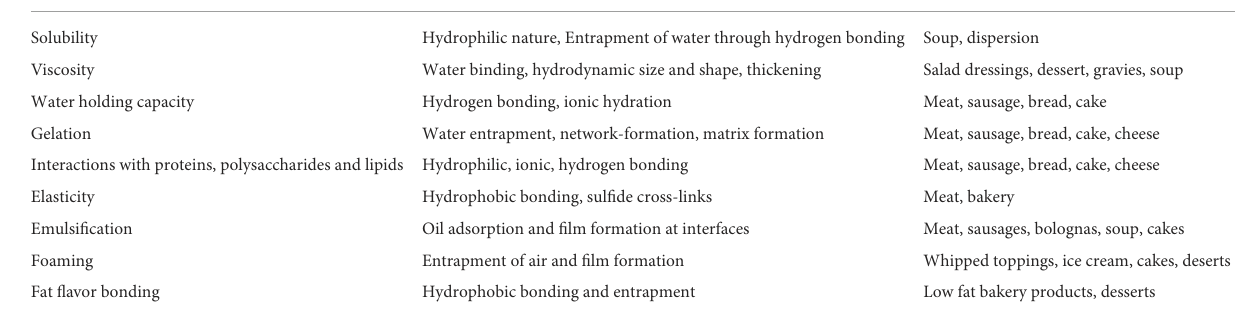
TABLE 4 Functional roles of muscle proteins in a food